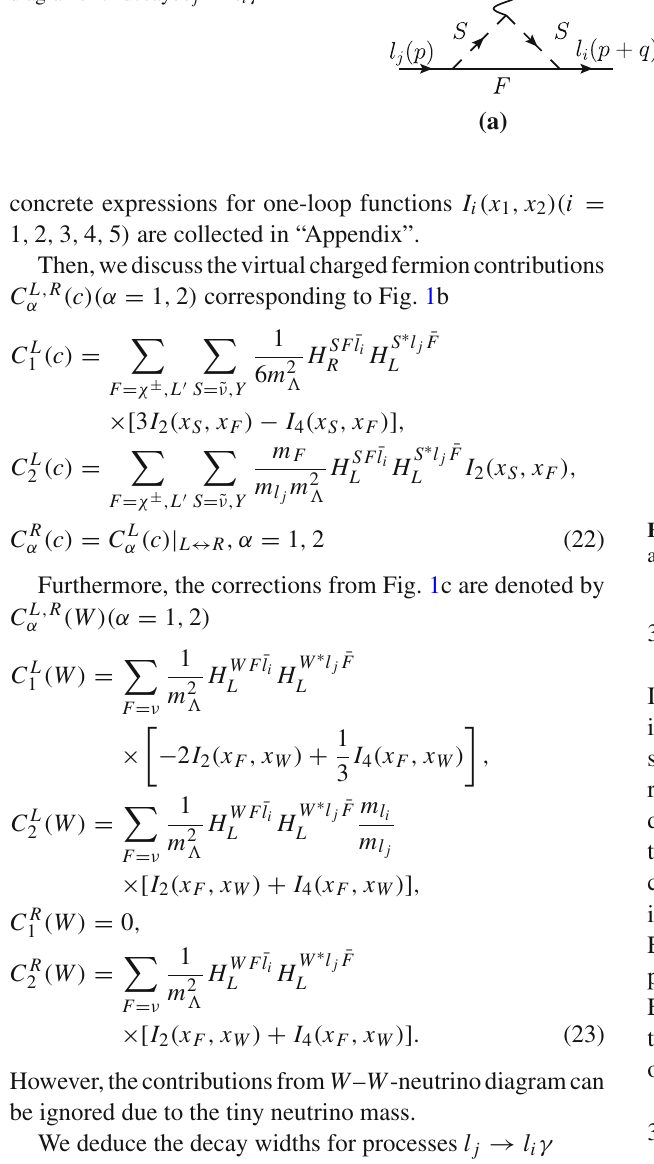
Fig. 1 The triangle type diagrams for decays l j → l i γ